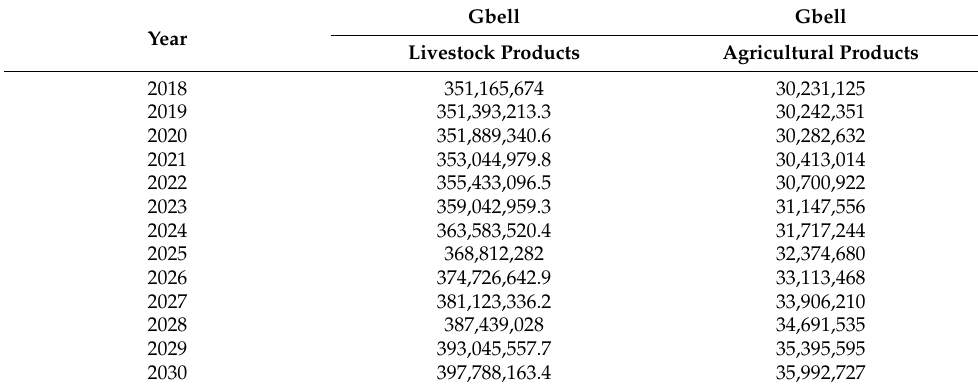
Table 6. Prediction of agricultural and livestock production in Iran.